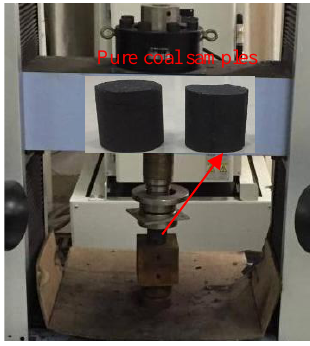
Figure 7. Short-term uniaxial creep tests on pure coal samples.